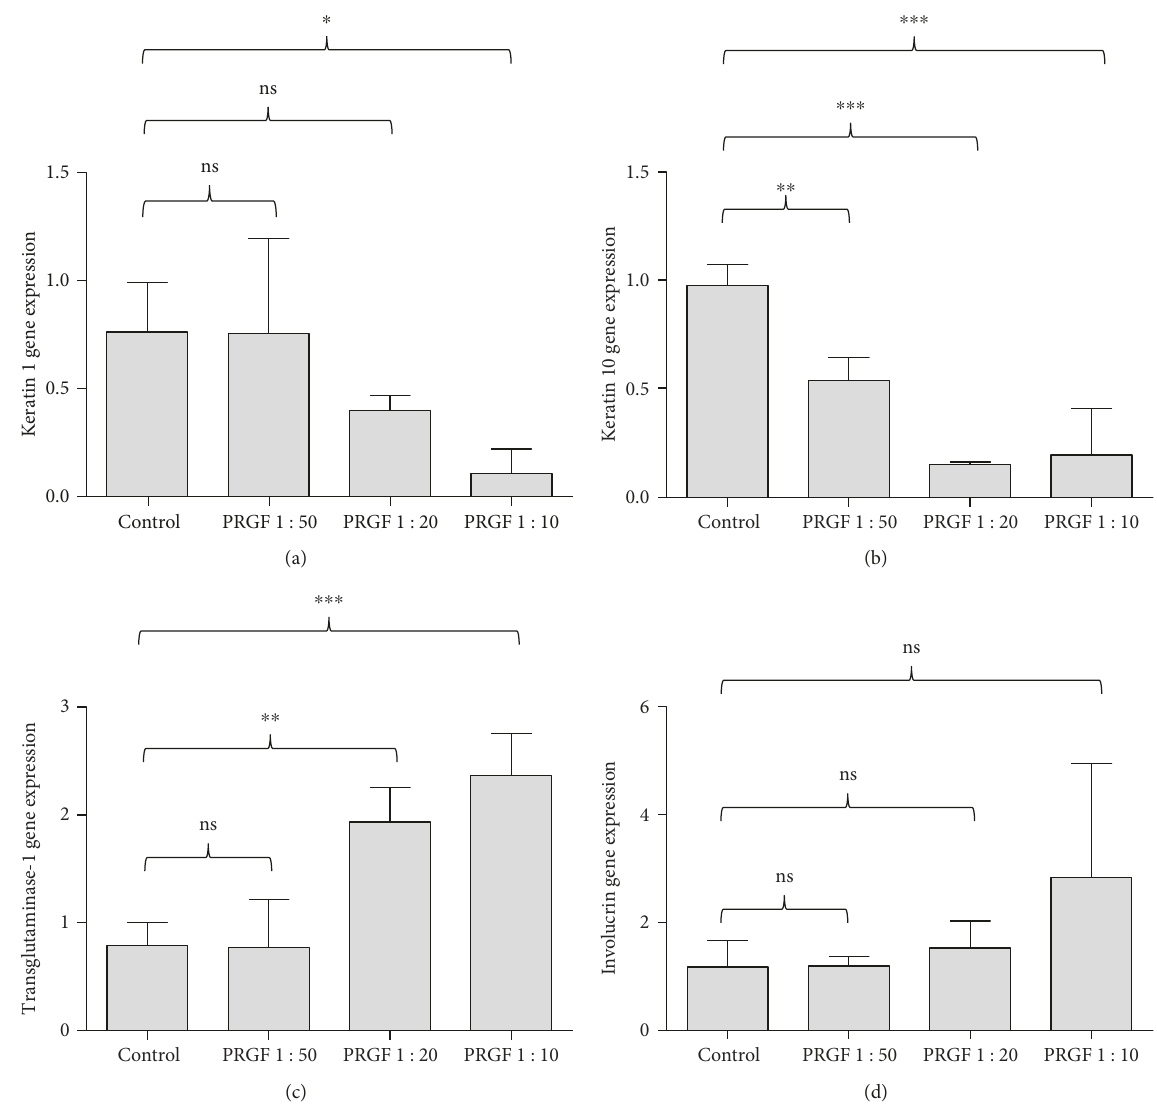
Figure 1: PRGF dose dependently in fl uences the expression of di ff erentiation markers in primary keratinocytes. PRGF stimulation of primary keratinocytes over 24 hours caused a dose-dependent decrease of keratin 1 (a) and keratin 10 (b) gene expression paralleled by a dose-dependent increase of transglutaminase-1 (c) and involucrin (d) gene expression (real-time PCR analysis, ∗ P < 0 05 , ∗∗ P < 0 01 , ∗∗∗ P < 0 001 , ns =not signi fi cant, one-way ANOVA with Tukey ’ s multiple comparison